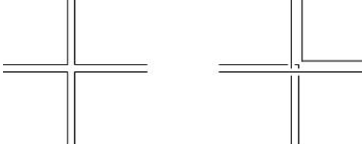
Figure 3. Left: the quartic vertex Φ a “mixed-up” matrix multiplication Φ a